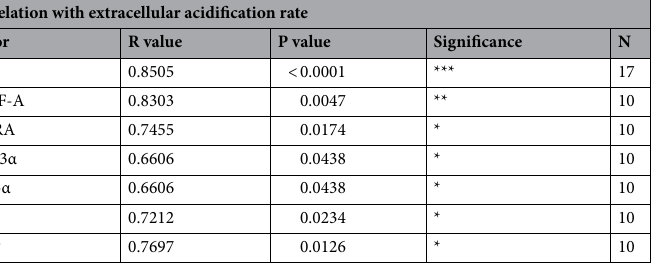
Table 2. Correlation of metabolic rate with protein secretions in matched OAC treatment-naïve biopsies. The protein secretions of 54 mediators analysed by multiplex ELISA were correlated with real-time metabolic rate readouts of ECAR of matched patient biopsies. ECAR, a measure of glycolysis, was significantly correlated with the rate of OCR and the secreted levels of 6 of 54 proteins including VEGF-A, IL-1RA, MIP-3α, TNF-α, IL-13 and TSLP in matched OAC treatment-naïve biopsies. Secretions from explant tissue and metabolic rate were normalised to protein content. Spearman correlations; Spearman r 0.4–0.59 moderate, 0.6–0.79 strong, 0.8–1.0 very strong; * p < 0.05, ** p < 0.01, *** p < 0.0001.